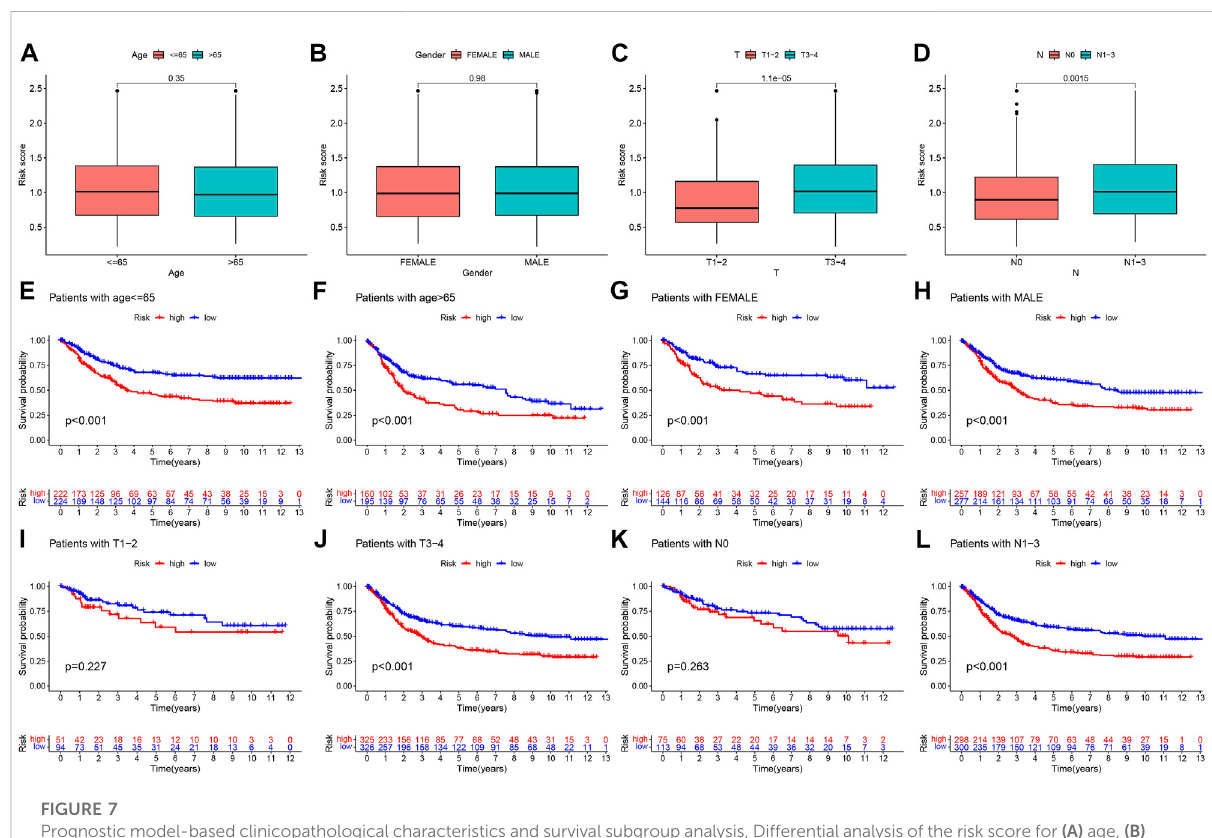
FIGURE 7 Prognostic model-based clinicopathological characteristics and survival subgroup analysis, Differential analysis of the risk score for (A) age, (B) gender, (C) Tstage,and (D) Nstagesubgroups.Kaplan-Meiersurvivalanalysisfor (E) age ≤ 65 years, (F) age > 65 years, (G) female, (H) male, (I) T1-2, (J) T3-4, (K) N0, and (L) N1-3 between high- and low-risk